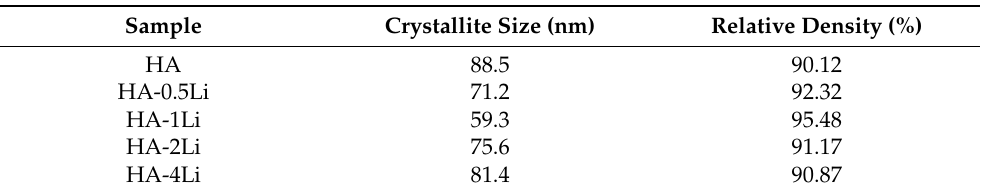
Table 2. The calculated values of average crystallite size (D) and relative density ( ρ ) of HA and Li-doped HA samples.